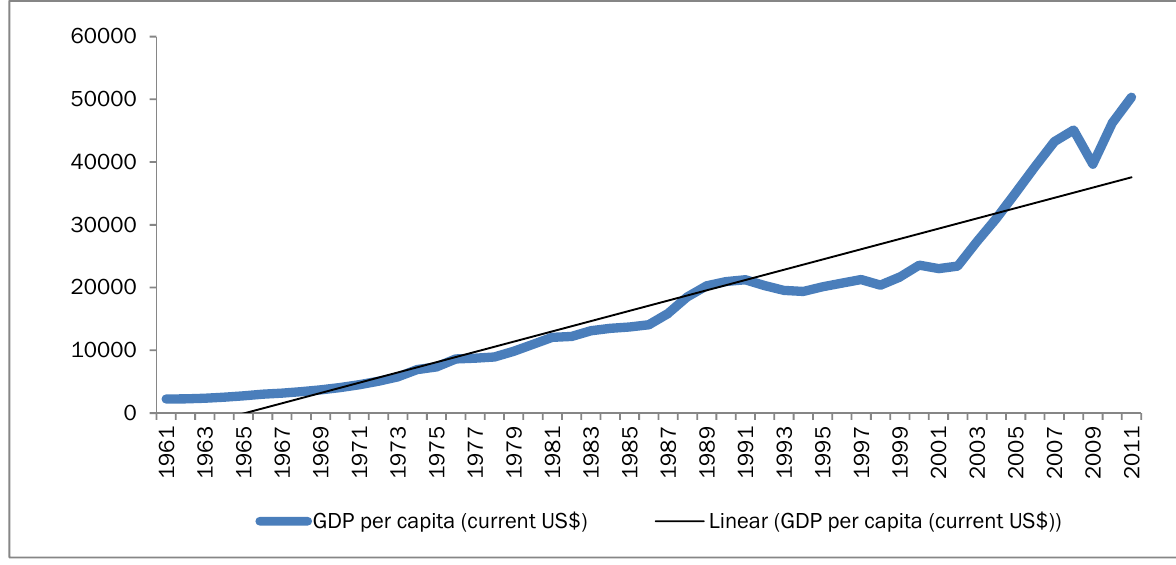
Figure 4. Canadian GDP per Capita in Current USD